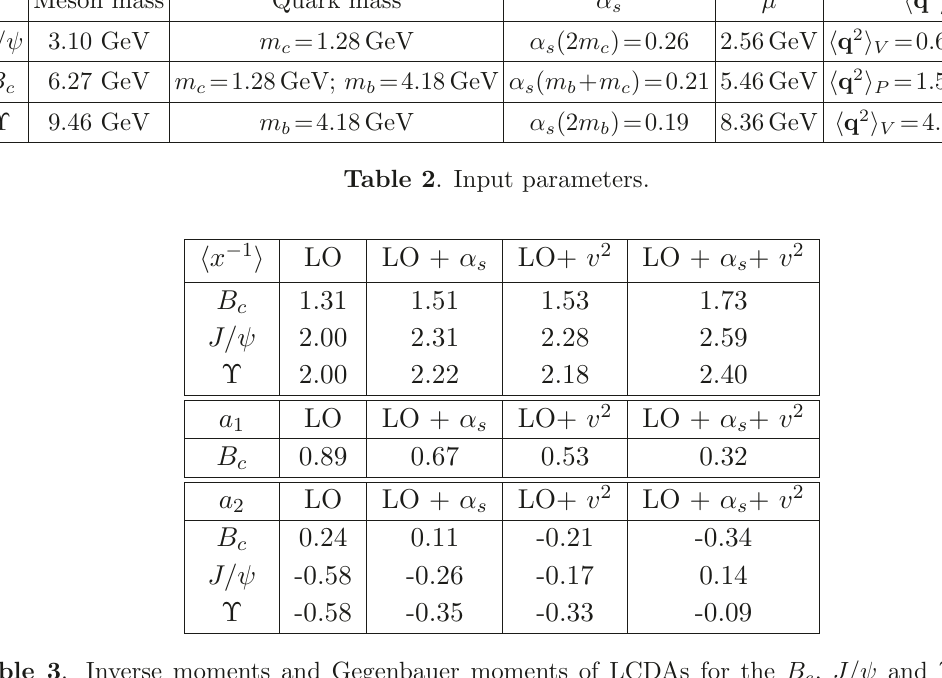
Table 3 . Inverse moments and Gegenbauer moments of LCDAs for the B c , J/ψ and Υ states, q 2 the used here are deduced by G-K relation. Leading-order results, one-loop QCD radiative h i corrections, relativistic corrections and the total results are shown,